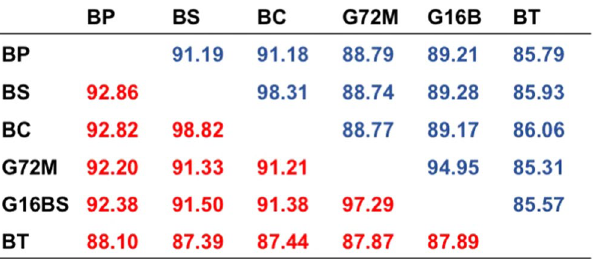
Figure 2. Percent identity matrix of mitogenomes. Blue and red colors show percent identity at nt and aa levels, respectively. At the nt level, whole mitogenome sequences were used. At the aa level, gene products for a given PCG were aligned and trimmed, then all 13 PCGs from a given mitogenome were